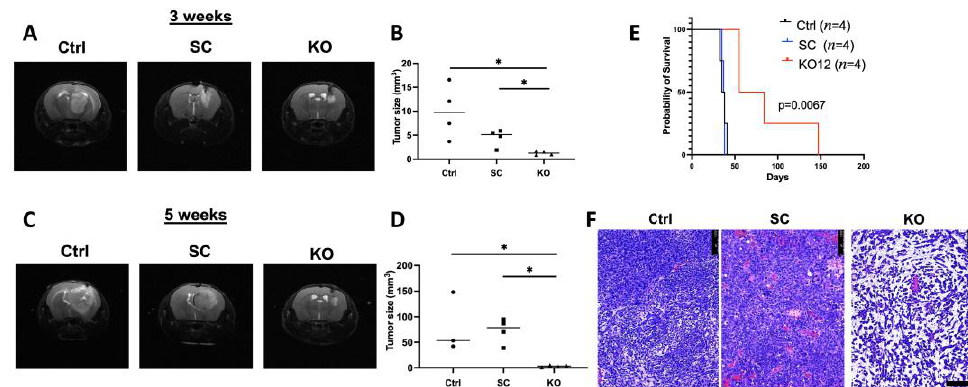
Figure 5. Deletion of TCF12 delays tumor growth in vivo. ( A ) T2 coronal MRI images of whole brain at 3 weeks post-injection of control GL261 tumor cells (Ctrl), scramble GL261 cells (SC), and TCF12 KO cells (KO). ( B ) Tumor sizes measured on MRIs at 3 weeks post-injection of Ctrl, SC and TCF12 KO GL261 tumor-bearing mice. ( C ) T2 coronal MRI images of whole brain at 5 weeks post-injection of Ctrl, SC, and TCF12KO GL261 tumor-bearing mice. ( D ) Tumor sizes were measured on MRIs at 5 weeks post-injection of control, scramble, and TCF12 KO tumor-bearing mice. ( E ) Kaplan–Meier survival curve of mice that were injected with Ctrl, SC, and TCF12KO GL261 cells. ( F ) H&E staining of in vivo tumors after euthanasia, scale bar 1000 µ m. * p < 0.05 ( B , D ). Circles mice recipient of scramble tumor cells; triangles: mice recipient of TCF12 Ko tumor cells.